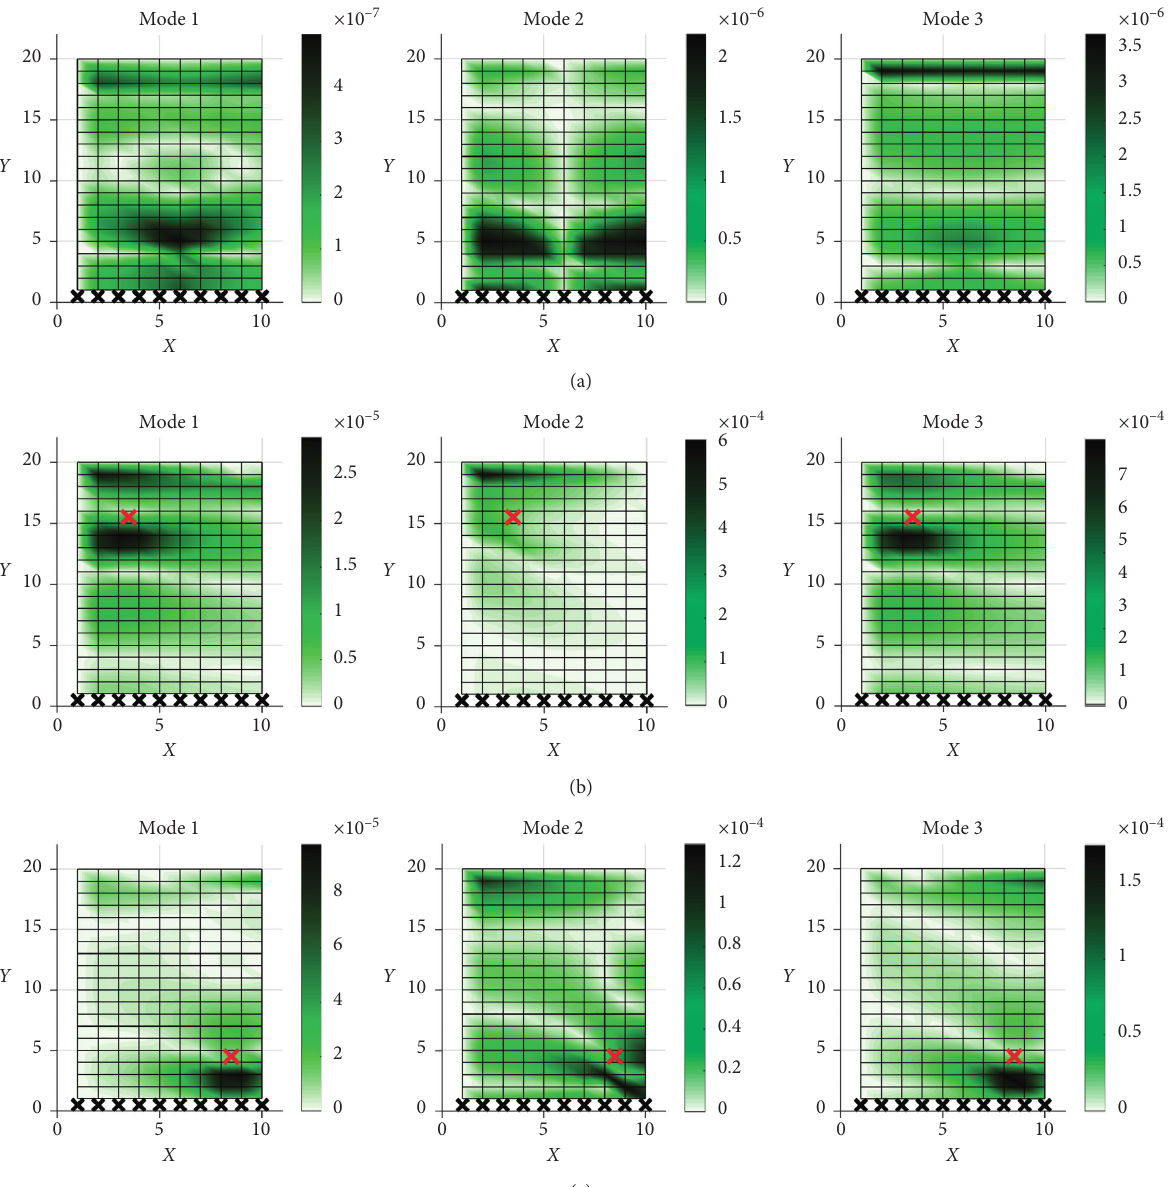
Figure 7: Wavelet-based damage detection for (a) S#7, (b) S#11, and (c) S#15 case. Black X marks refer to fix. Red X marks refer to damage